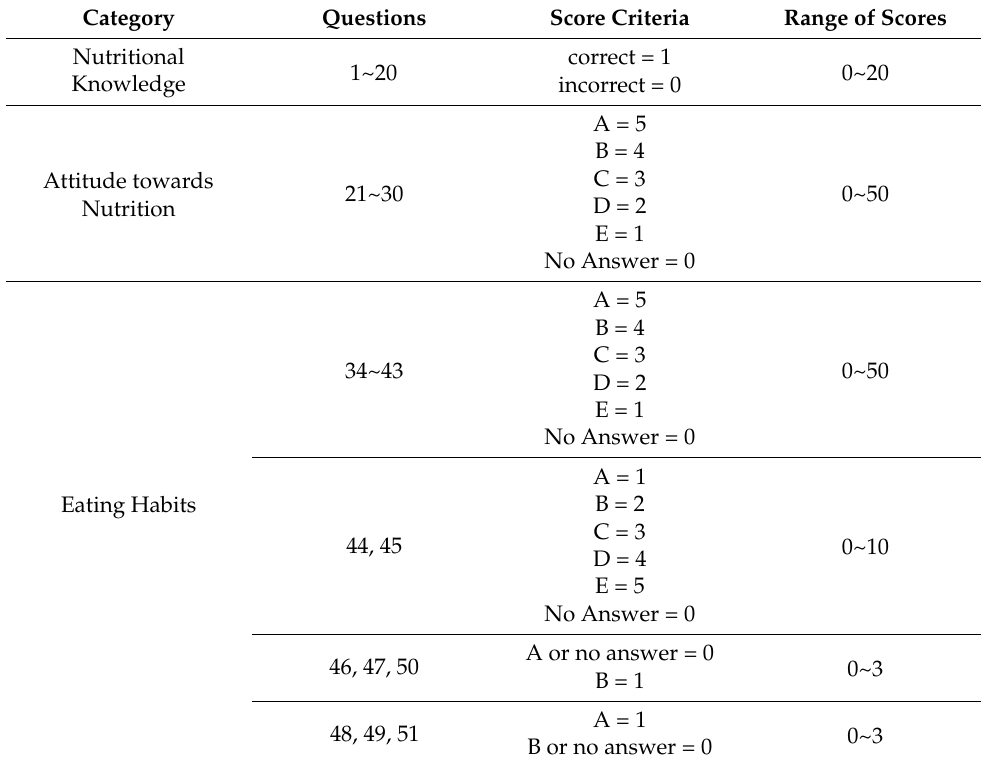
Table 1. Criteria for athlete nutrition KAP